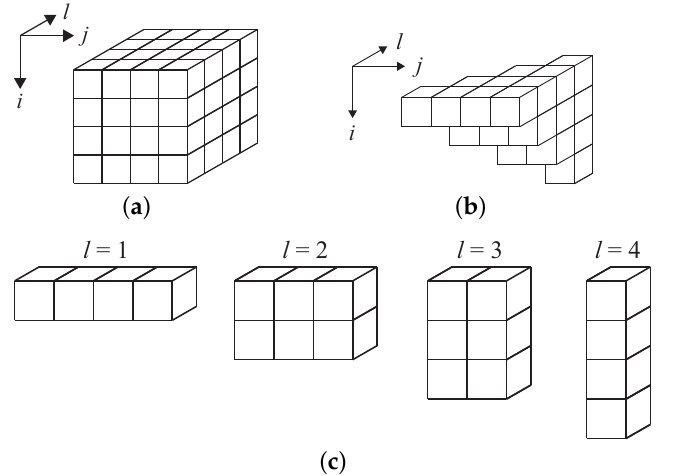
Figure 2. Third-order Volterra kernel considering its symmetry characteristic and its separated layers. ( a ) All elements ( N = 4). ( b ) Elements required for convolution. ( c ) Elements of each